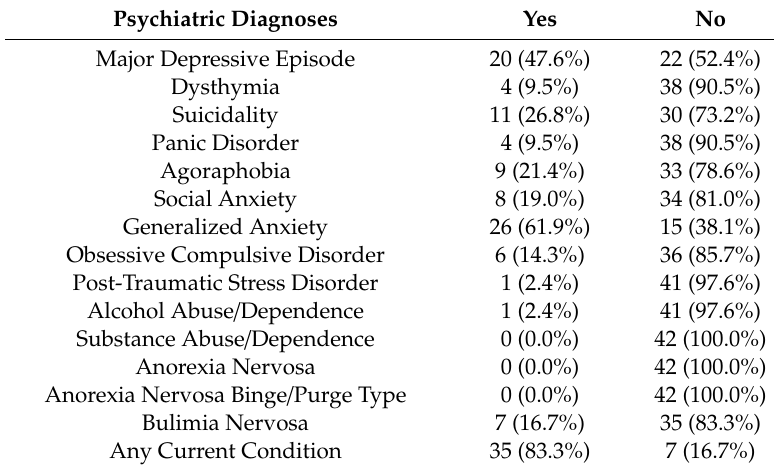
Table 1. Frequencies of current psychiatric conditions met by participants using the Mini International Neuropsychiatric Interview